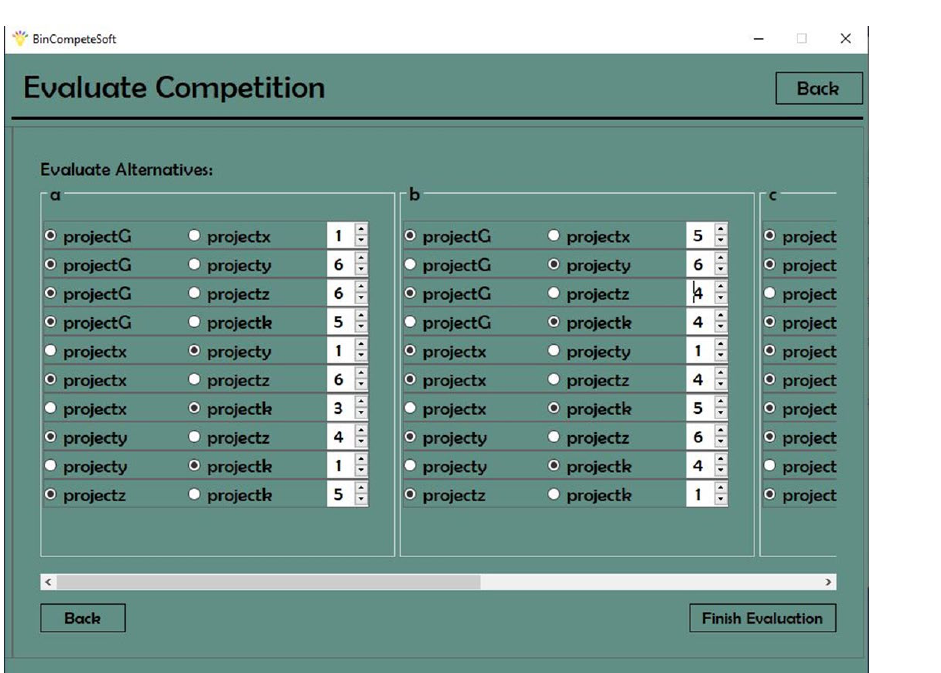
Figure 9. Evaluation of the projects using the AHP